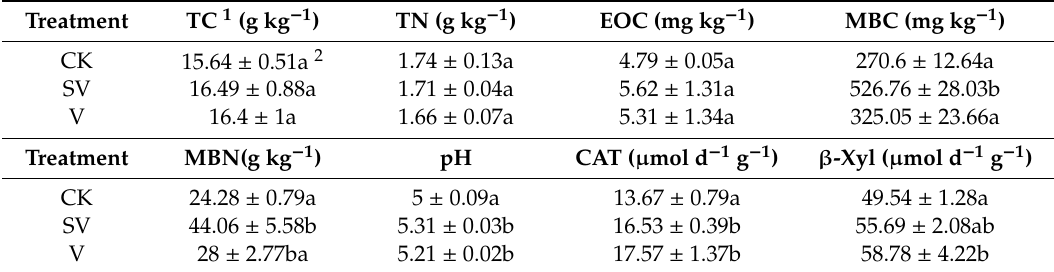
Table 1. E ff ect of CMV and rice straw on soil factors.